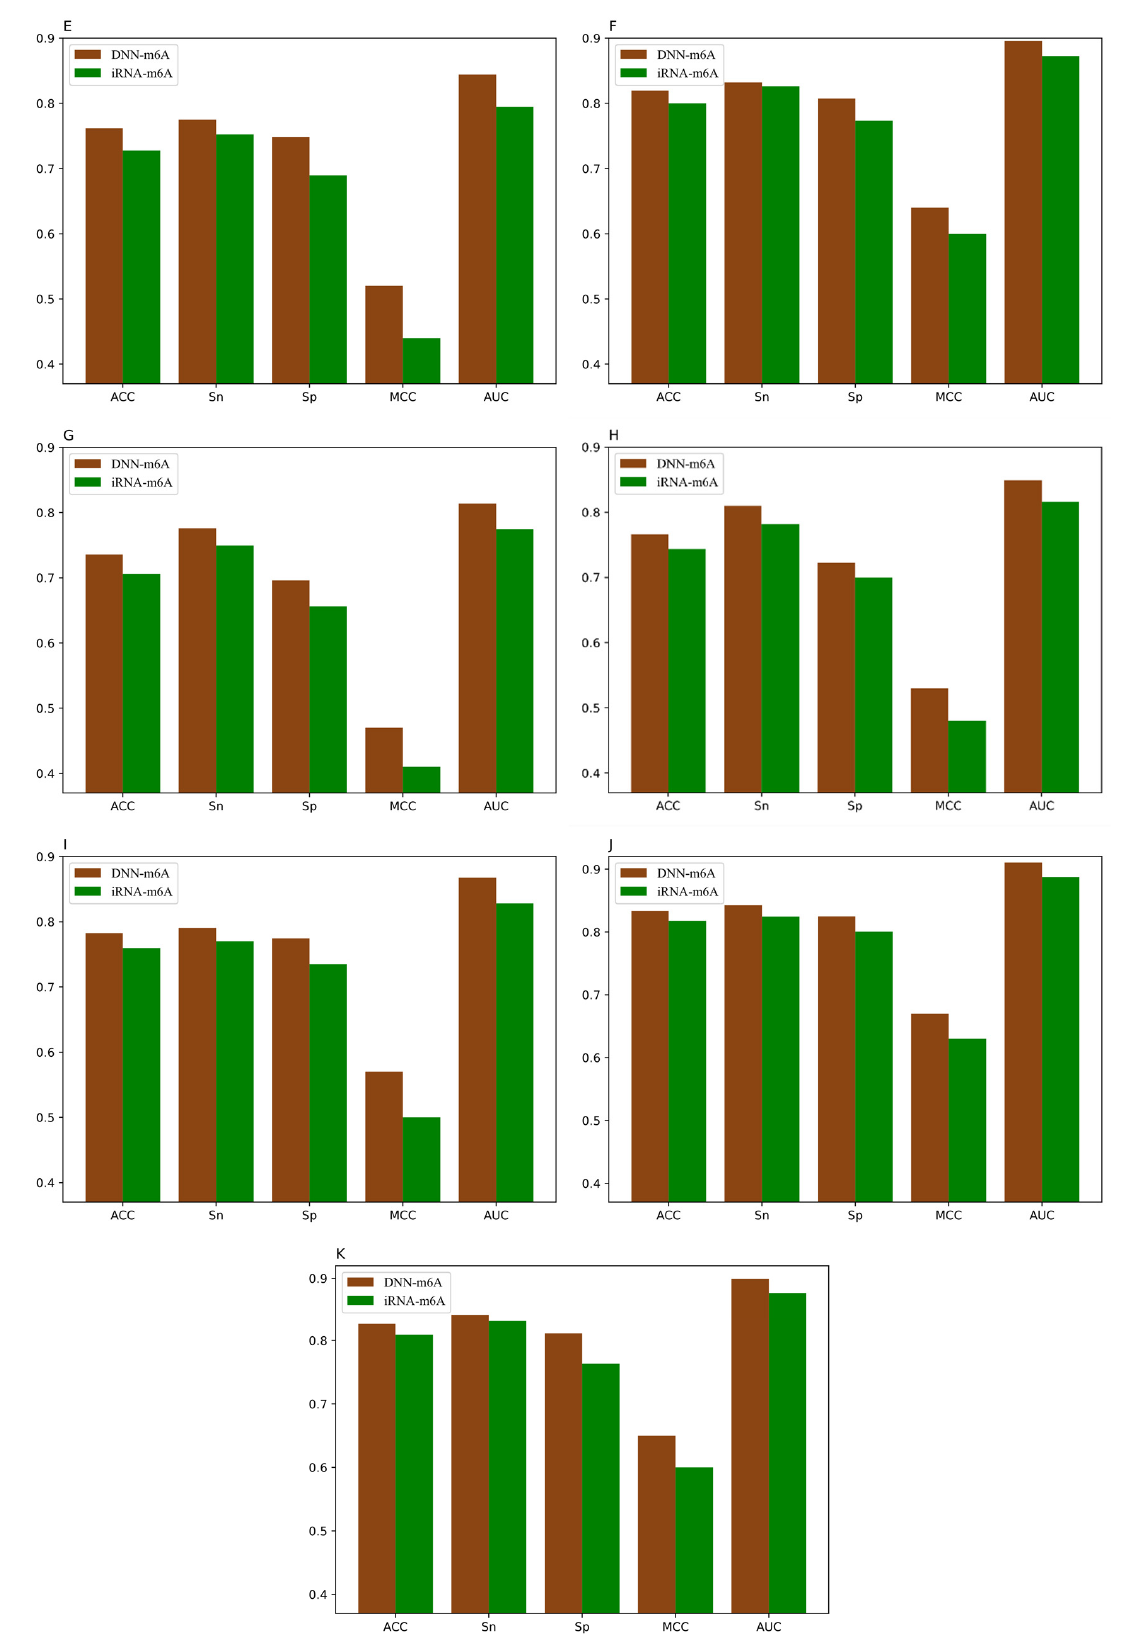
Figure 7. Performance of iRNA-m6A and DNN-m6A on eleven tissues’ training datasets ( A ) H_B, ( B ) H_K, ( C ) H_L, ( D ) M_B, ( E ) M_H, ( F ) M_K, ( G ) M_L, ( H ) M_T, ( I ) R_B, ( J ) R_K, and ( K ) R_L.